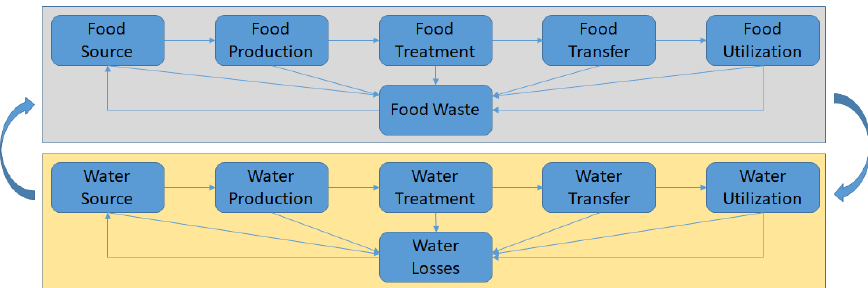
Figure 3. Proposed modeling of hybrid food–water interconnected systems.